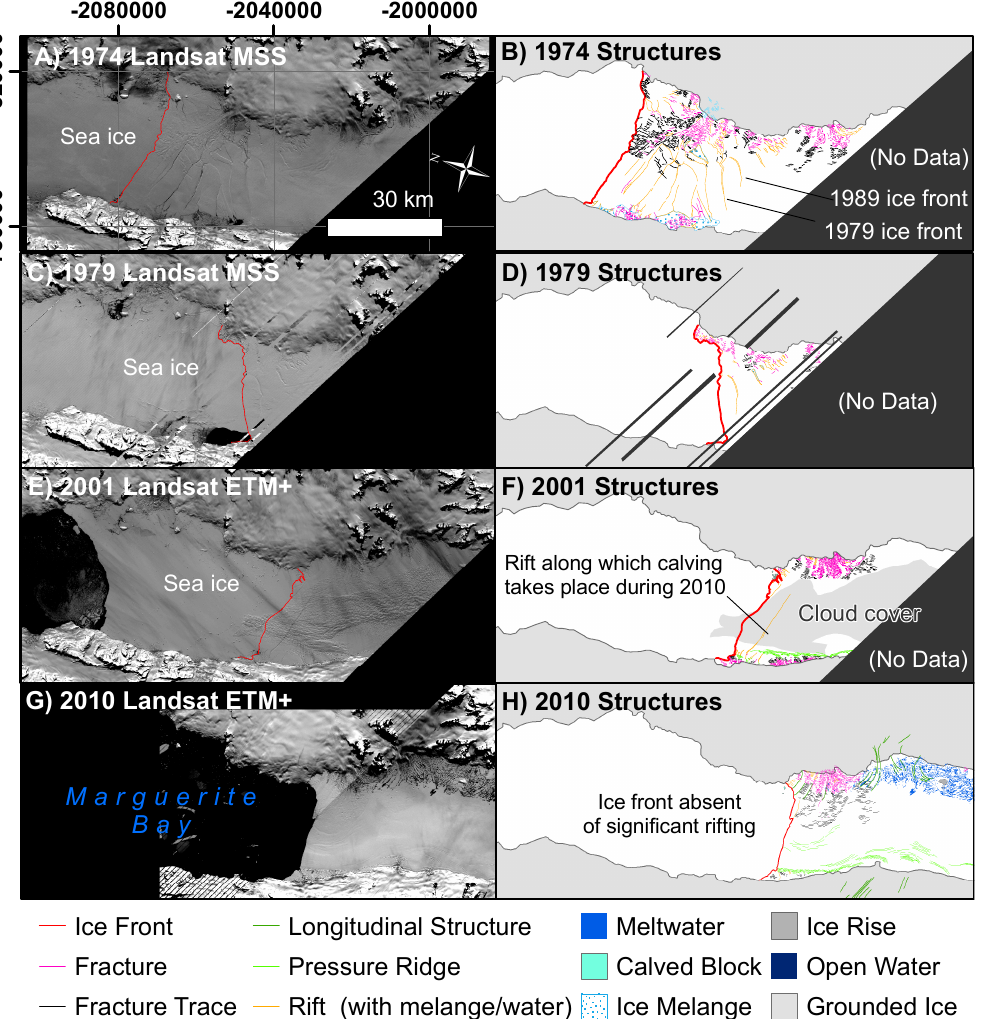
Fig. 4. Structural evolution at the north ice front illustrating widespread rifting that encouraged retreat. Note the long-term development of rifts (B) from the eastern grounding line that eventually form the frontal profile during 1979 and 1989. Post 2001 there are few ice-shelf-wide rifts at the northern ice